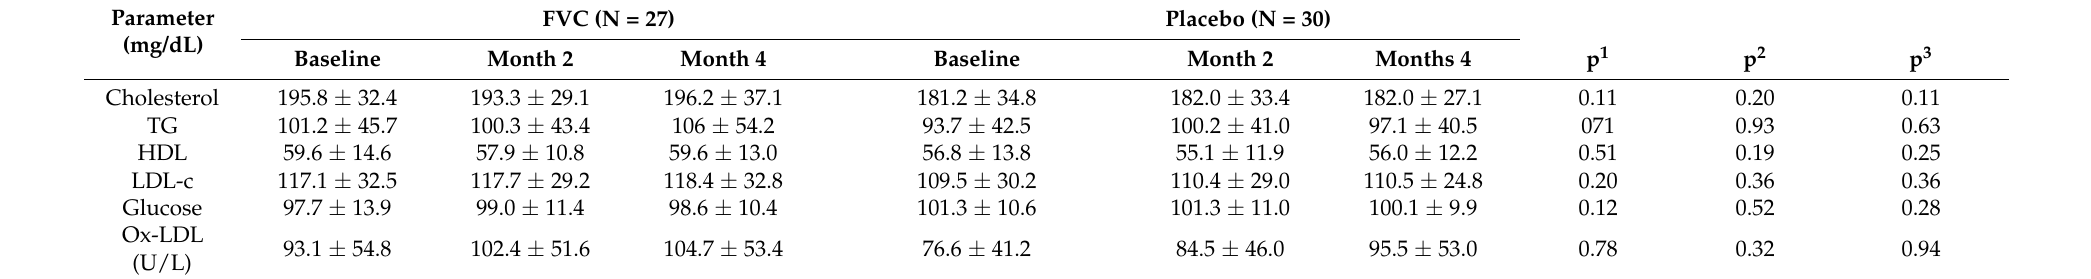
Table 2. Fasting lipid and glucose levels for FVC vs. Placebo at baseline and month 2 and 4.